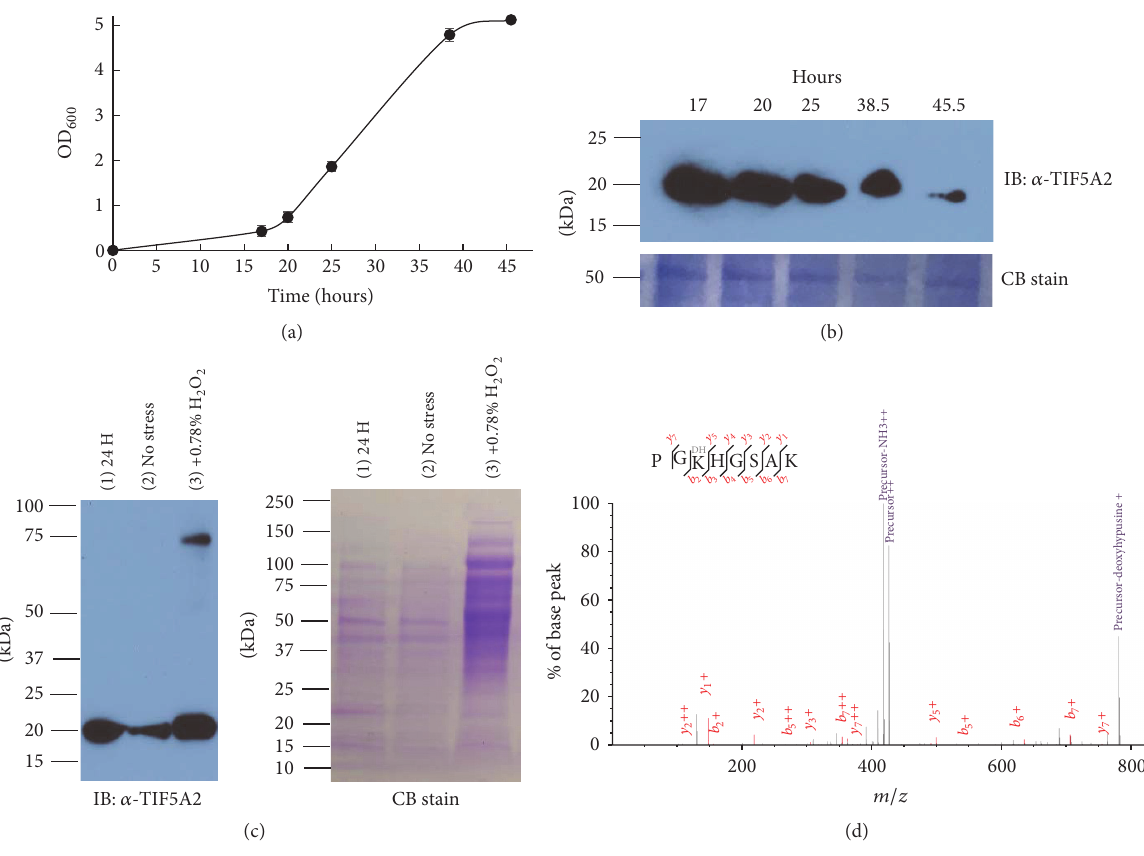
Figure 3: aIF5A produced in Hfx. volcanii is deoxyhypusinylated and sensitive to oxidative stress. (a) Hfx. volcanii H26 was grown at 42 ∘ C in ATCC974 (shaking at 200 rpm). 2 mL of samples at OD 600 = 0.043 was harvested along the growth curve. (b) H26 cells pellets (2mL at OD 600 = 0.043 of the culture) were resuspended in SDS-PAGE loading buffer and boiled for 15 min. Equivalent protein loading was based on OD 600 of cell culture (0.086 OD 600 units per lane), as demonstrated by staining with Coomassie Brilliant Blue R-250 (CB stain, with representative 55 kDa protein band of Hfx. volcanii presented). Proteins were separated via 4–15% reducing SDS-PAGE. aIF5A was detected by 𝛼 -aIF5A (anti-TIF5A2) immunoblot (IB). The experiments were performed with three biological replicates and the detection by anti-TIF5A2 or anti- TIF5A3. The molecular mass indicated is in kDa. (c) Effect of oxidative stress on aIF5A level. The cells were grown for 24 hours and then treated or not treated with 0.78% H 2 O 2 . Equivalent protein loading was based on OD 600 of cell culture (0.086 OD 600 units per lane). Lane 1, cells collected at 24 hours; lane 2, cells collected at +4 hours after no stress (control experiment); lane 3, cells collected at +4 hours after 0.78% H 2 O 2 treatment. Proteins were separated by 4–15% reducing SDS-PAGE. aIF5A was detected via 𝛼 -aIF5A (anti-TIF5A2) immunoblot (IB). The molecular mass indicated is in kDa. (d) Identification of the deoxyhypusine modification by LC-MS/MS analysis. The purified aIF5A His-C-term was loaded on a SDS-PAGE 12%. The proteins were detected by staining with Coomassie Blue (Fig S2B), and the protein band was cut and analyzed by LC-MS/MS analysis. Fragmentation spectrum for deoxyhypusinylated peptide PGK HGSAK is shown; xiSPEC (http://spectrumviewer.org/) was used for